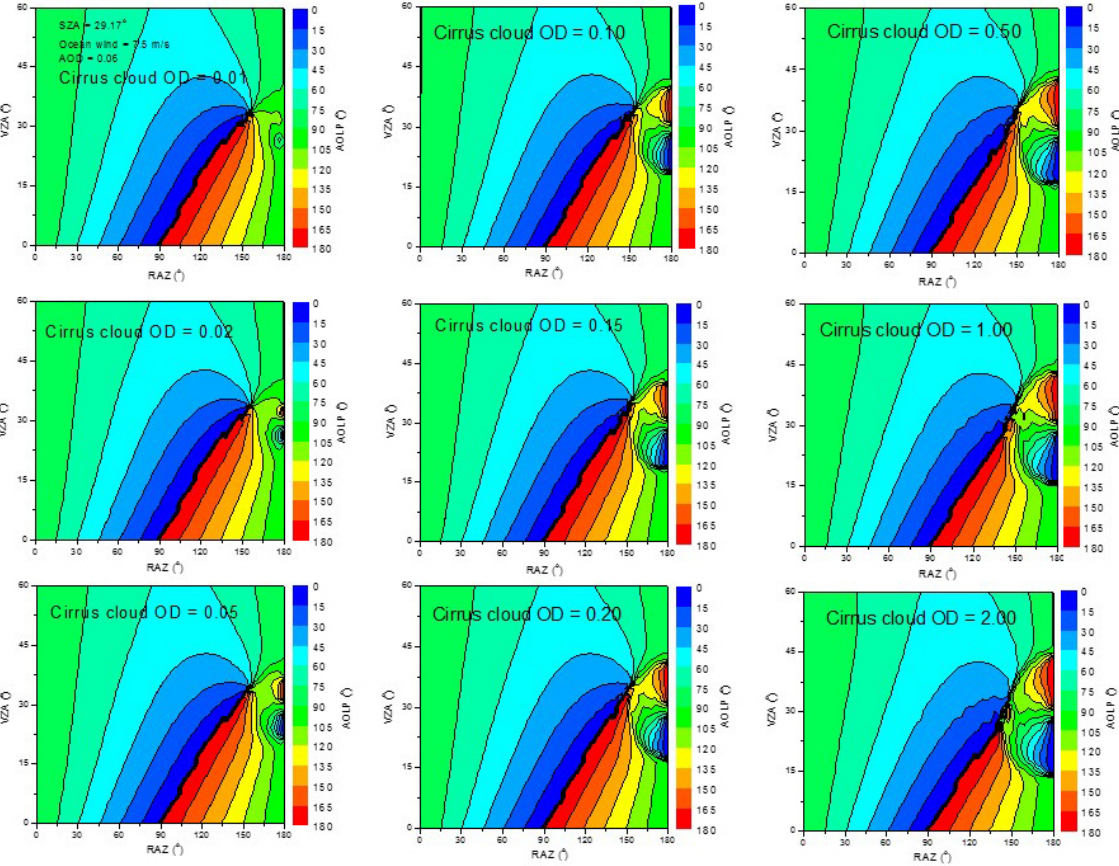
Figure 2. The modeled AOLP of reflected sunlight at a wavelength of 670nm from cirrus clouds (hexagonal column particle shapes). In the ADRTM modeling, the clouds’ optical depths (OD) are set from 0.01 to 2.0, the ocean wind speed is assumed to be 7.5ms − 1 , the solar zenith angle (SZA) is 29.17 ◦ , and the aerosol optical depth (AOD) is 0.06. The size distribution of the ice particles in the cirrus clouds is from Heymsfield and Platt (1984) for the cloud temperature of − 20 to − 25 ◦ C. The cirrus clouds are assumed to be composed of solid hexagonal column ice crystals with aspect ratios as given in Fu et al. (1998). Similar to water clouds, cirrus clouds composed of hexagonal column ice crystals exhibit the p -polarization feature, even when their OD is ∼